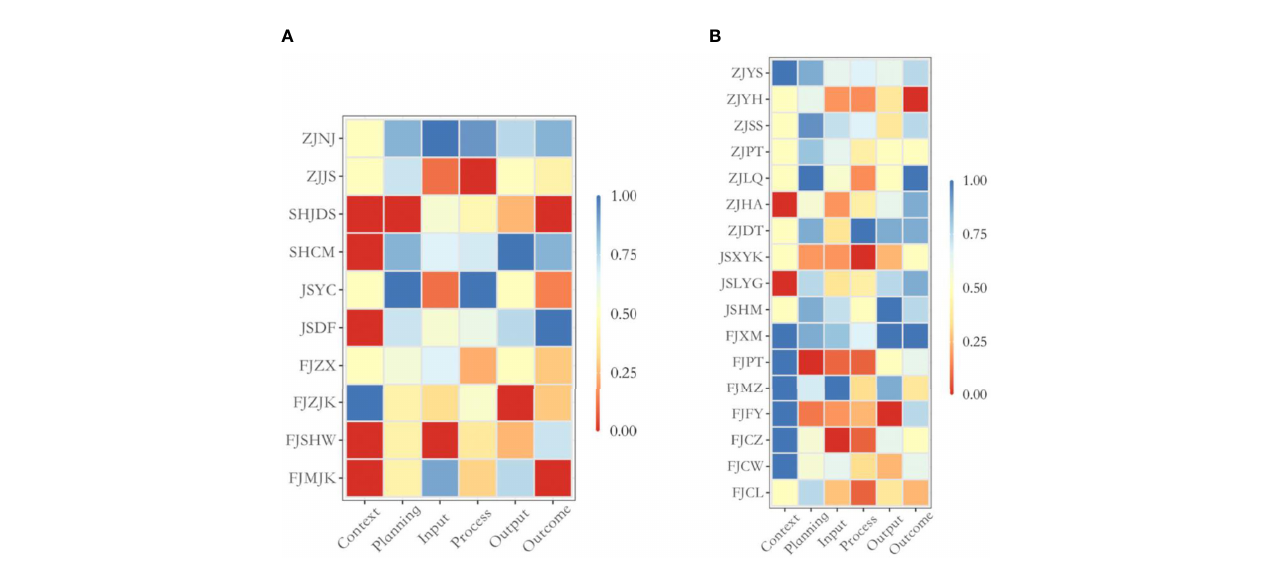
FIGURE 2 Results of the six components assessment of the 27 protected areas in this study: (A) MNRs (B) MSRs. Abbreviations are the names of the protected areas; see Table 3.